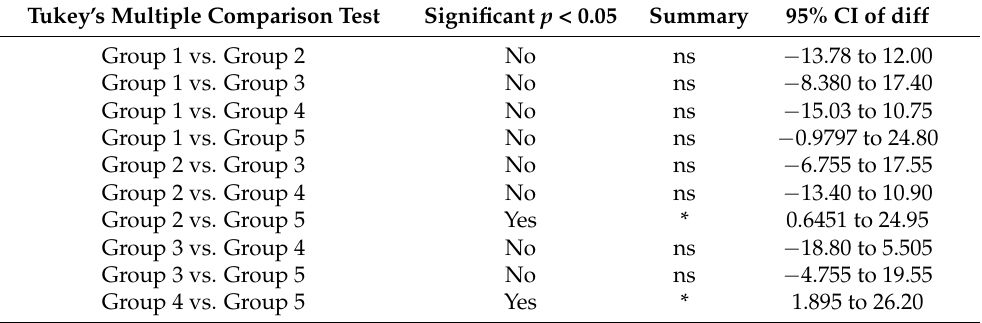
Table 10. Tukey test showing the groups that showed a statistically significant difference in baseline levels.